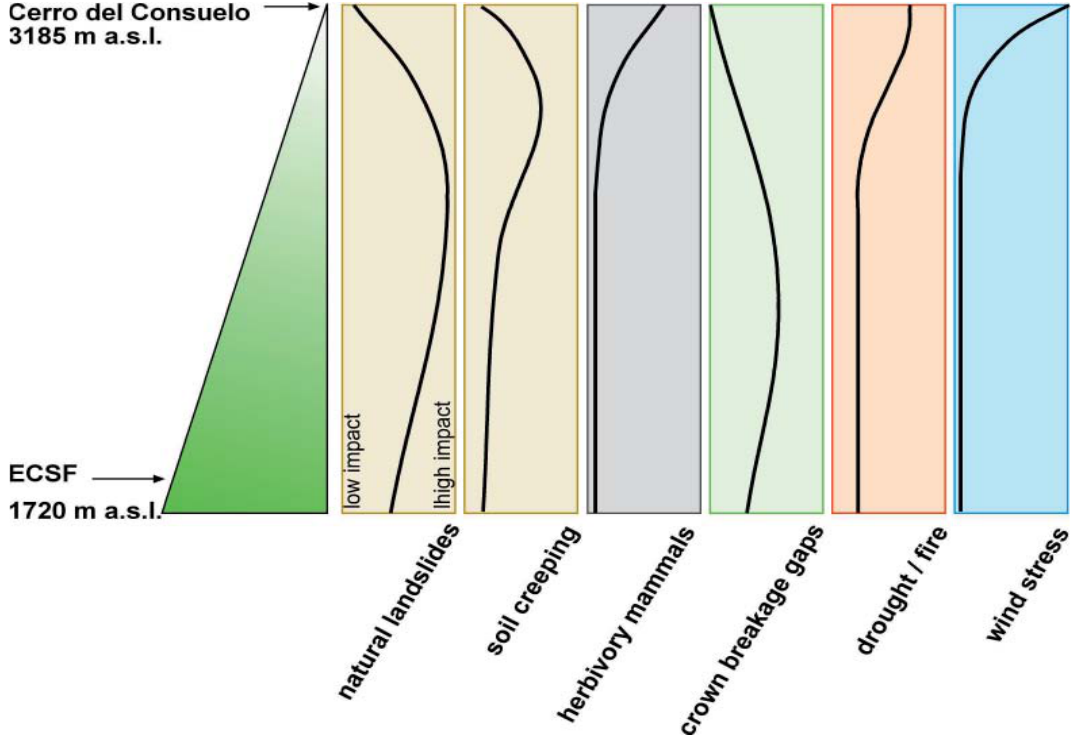
Figure 18: Important disturbance regimes in the RBSF-terrain and their relevance along the altitudinal